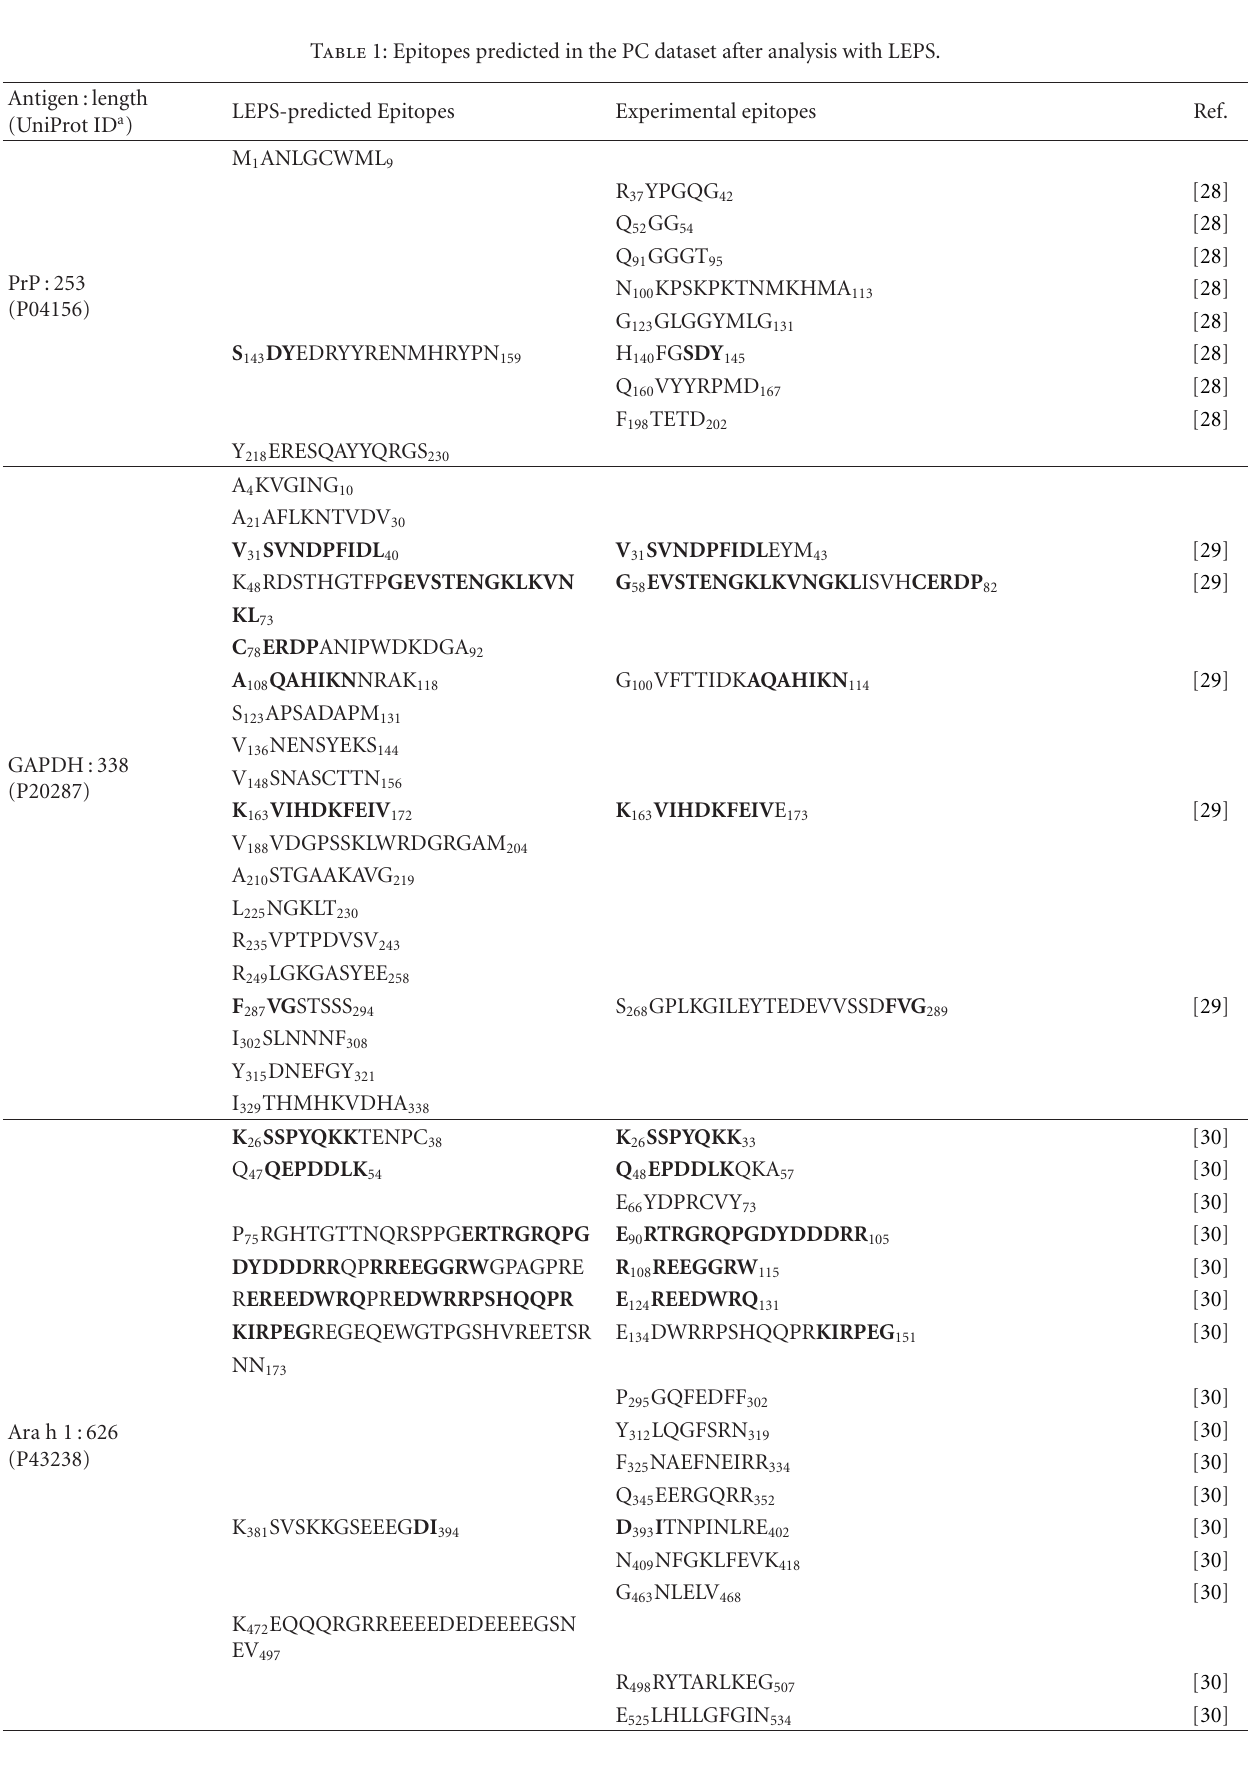
Table 1: Epitopes predicted in the PC dataset after analysis with LEPS.